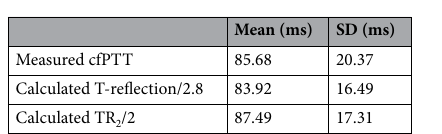
Table 2. Results of measured cfPTT and calculated time delay using different